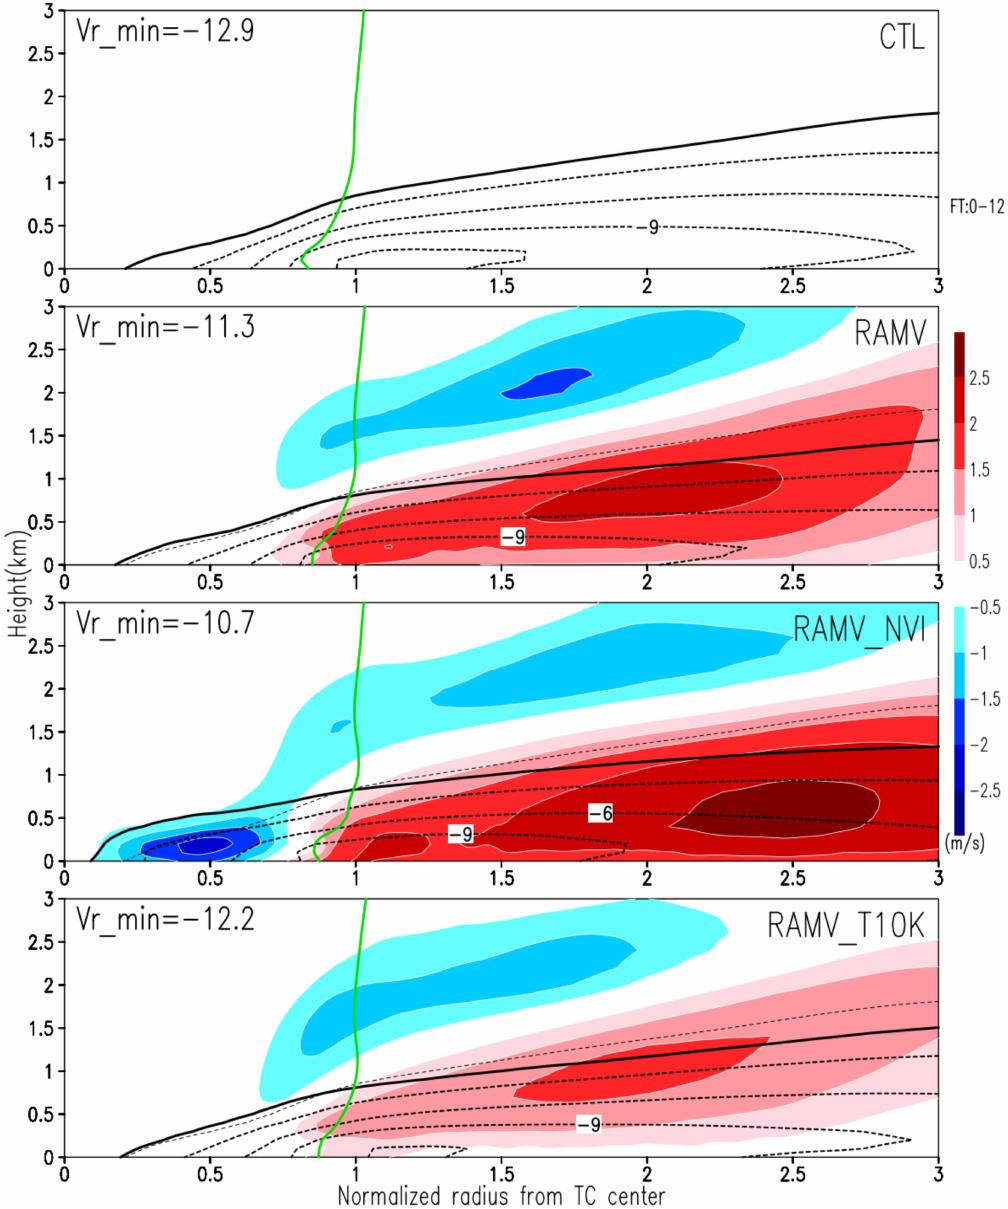
Figure 9. As in Figure 8, but for radial wind azimuthally and temporally averaged for FT = 0–12 h. Note that negative values in contour indicate the radial inflows and red color areas are positive anomalies from CTL, meaning that the weakening of radial inflows to